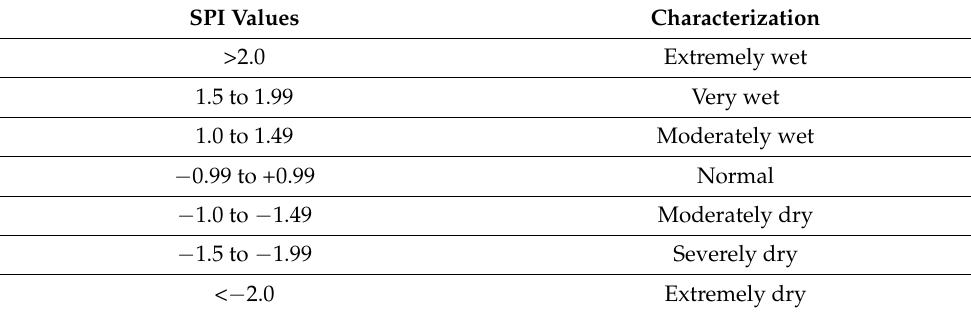
Table 2. SPI classification according to McKee et al. Table 2 . SPI classification according to McKee et al. (1993).